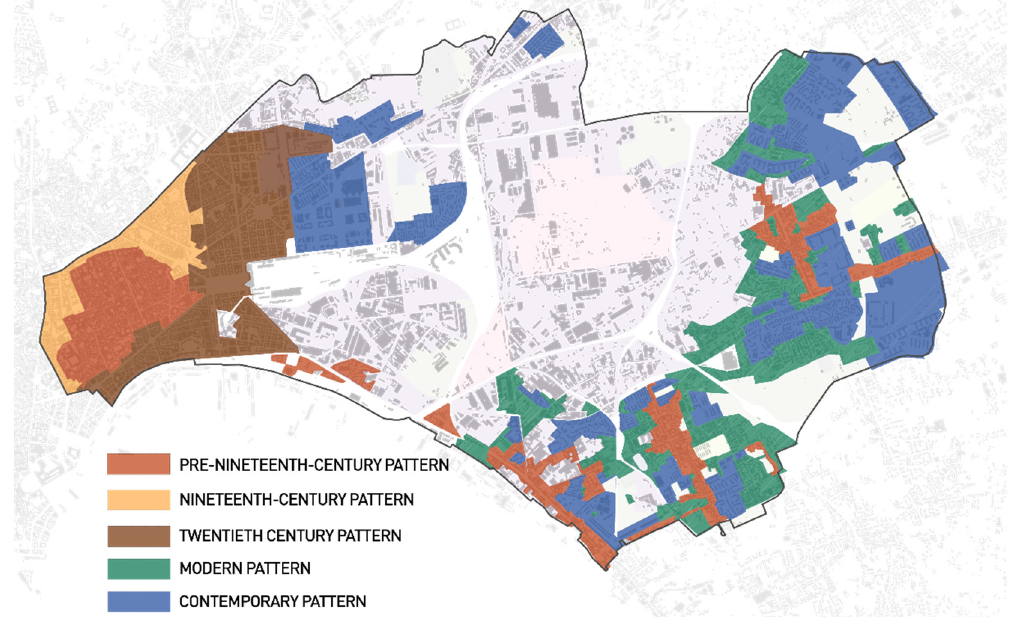
Figure 3. Identification of morphologically homogeneous urban patterns.